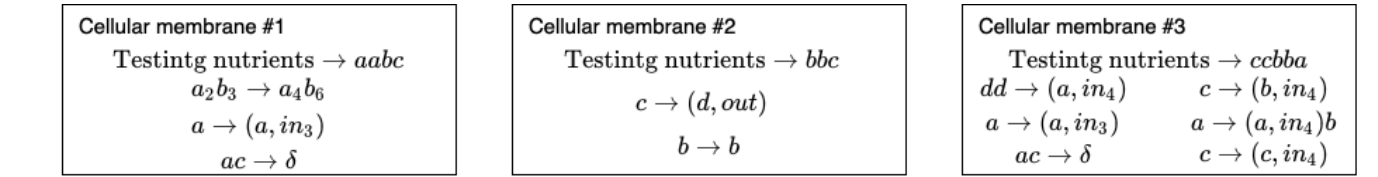
Figure 5. A three-membrane system brings a simple membrane system designed to calculate a random number.